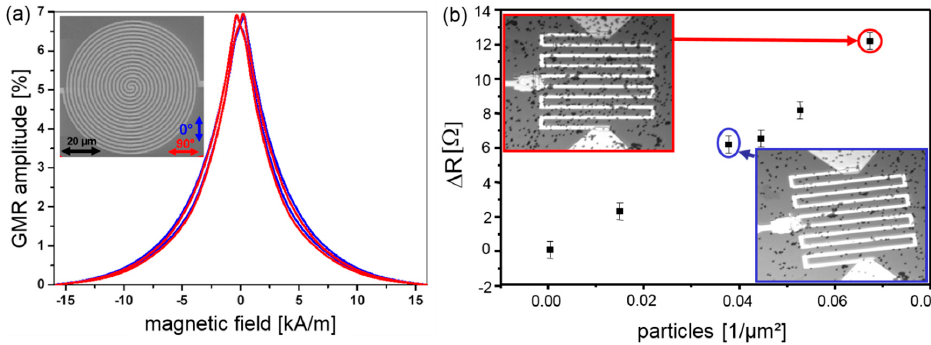
Figure 11. ( a ) Isotropic GMR characteristic measured at room temperature for a spiral shaped GMR sensor for two in-plane fields oriented perpendicular to each other; ( b ) Change in the resistance of meander shaped GMR sensors, each with an area of 100 × 100 µm 2 , as a function of particle density. The SEM images show the particle coverage of the sensors corresponding to the measurements marked by colored circles (data taken from from